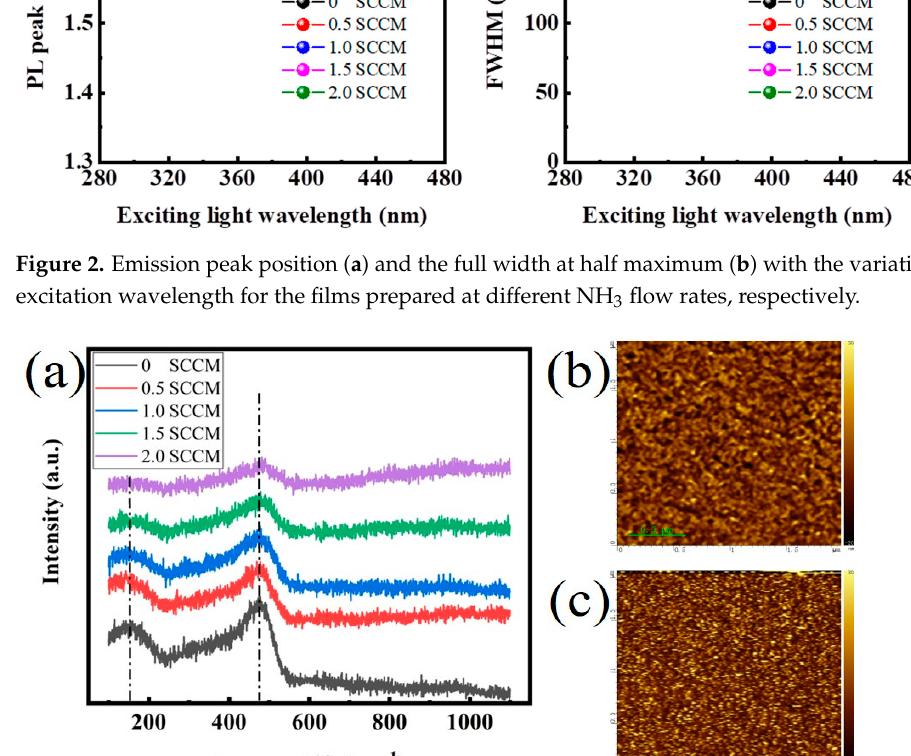
Figure 3. ( a ) Raman scattering spectra of the films prepared at different NH 3 flow rates, ( b , c ) atomic force microscopic images of the films prepared by different NH 3 flow rates of 1 sccm and 2 sccm, respectively.